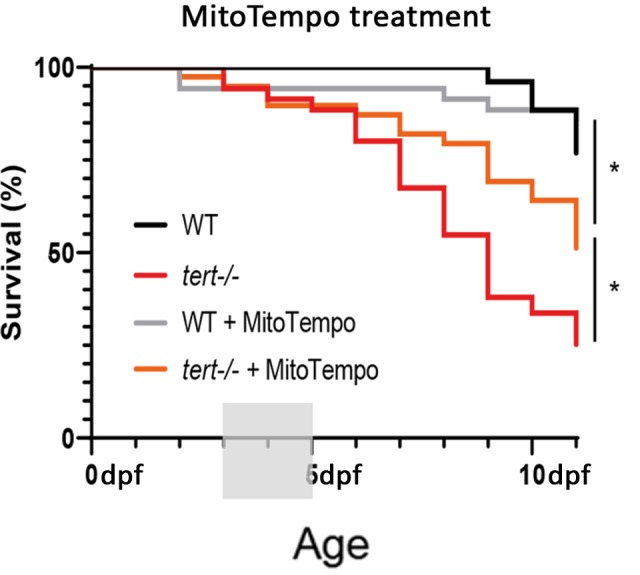
Pharmacological administration of ROS scavengers increases survival of G2 tert-/-.Survival curve of G2 tert-/- upon MitoTempo (10 µM from day 3 to 5) treatment. (WT N = 26; WT+MitoTempo N = 35; G2 tert-/- N = 35: G2 tert-/- +MitoTempo N = 39 fish; * p-value<0.05 using Log-rank test).Figure 6—figure supplement 2—source data 1.Survival analysis upon MitoTempo treatment, as plotted in Figure 6—figure supplement 2.